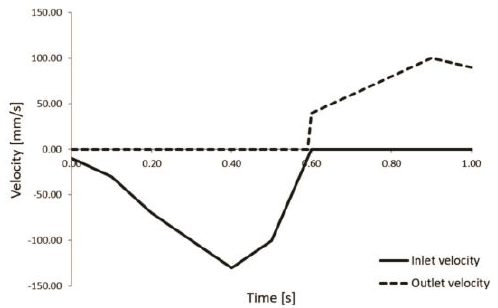
Figure 9. Prescribed inlet and outlet velocities for aortic output and mitral input.